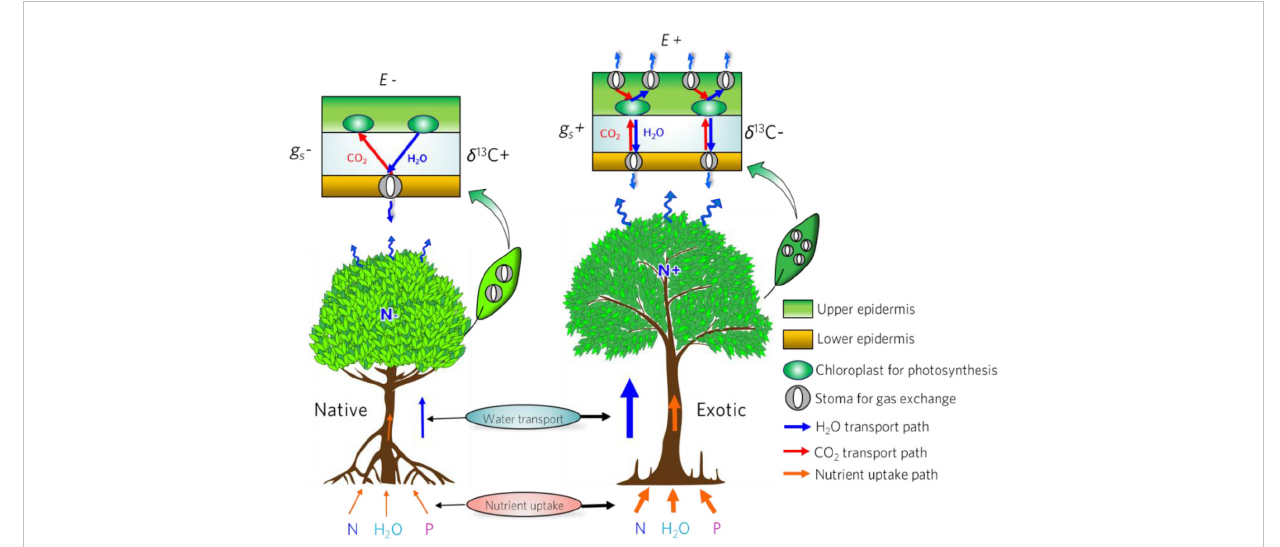
FIGURE 5 Conceptional diagram for linking stomatal traits to foliar gas exchange performance in native mangroves (right) and exotic mangrove (left) N- nitrogen ability, E -transpiration, g s - conductance, d 13 C-the stable carbon isotope of mangrove